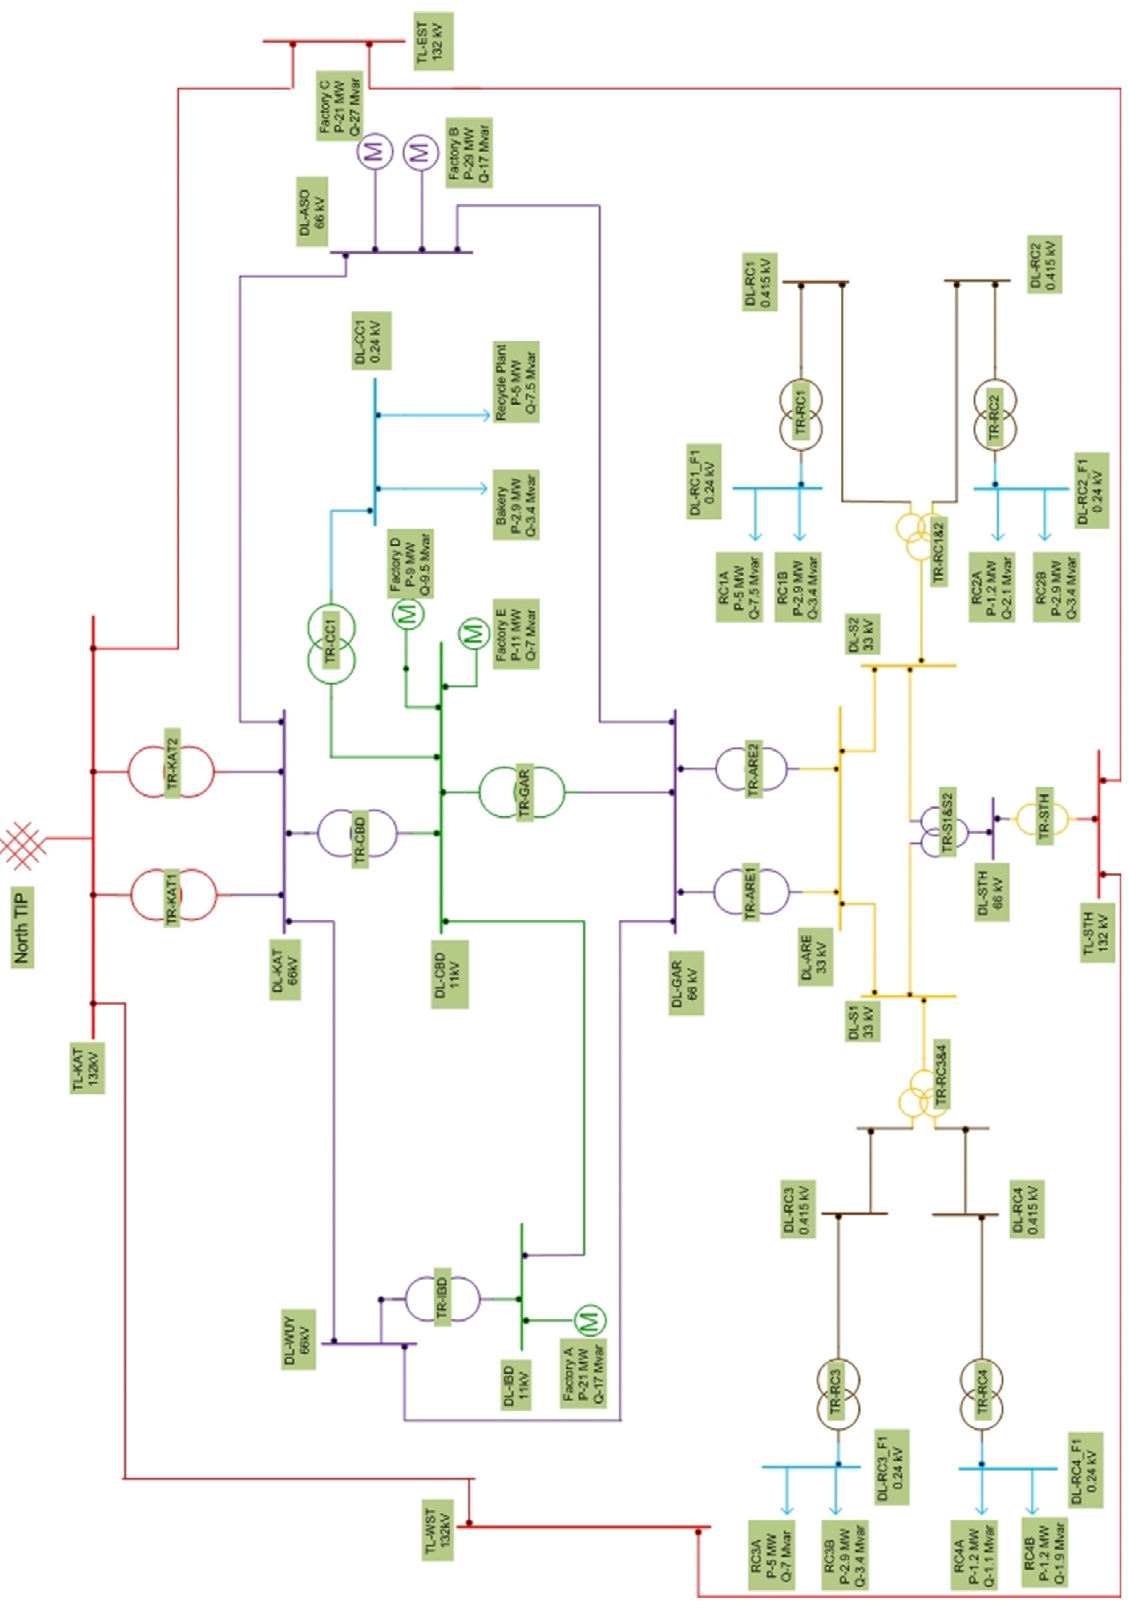
Figure 1. Benchmark Transmission and Distribution Network Design.